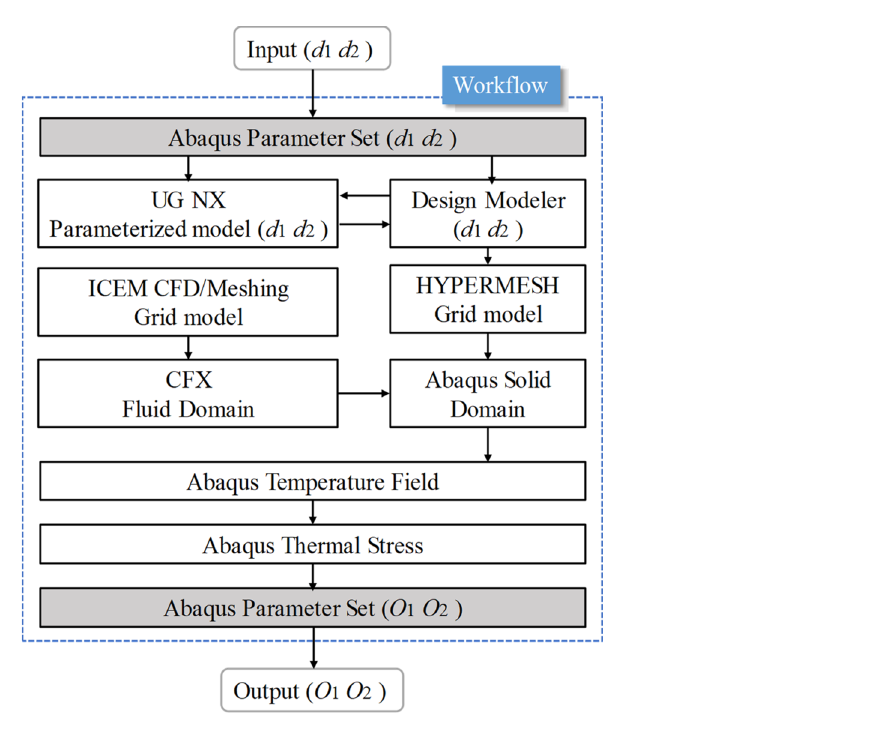
Figure 4. Thermal boundary condition of piston top surface under the ( a ) cold start condition, ( b ) urgent acceleration condition and ( c ) rapid deceleration condition.